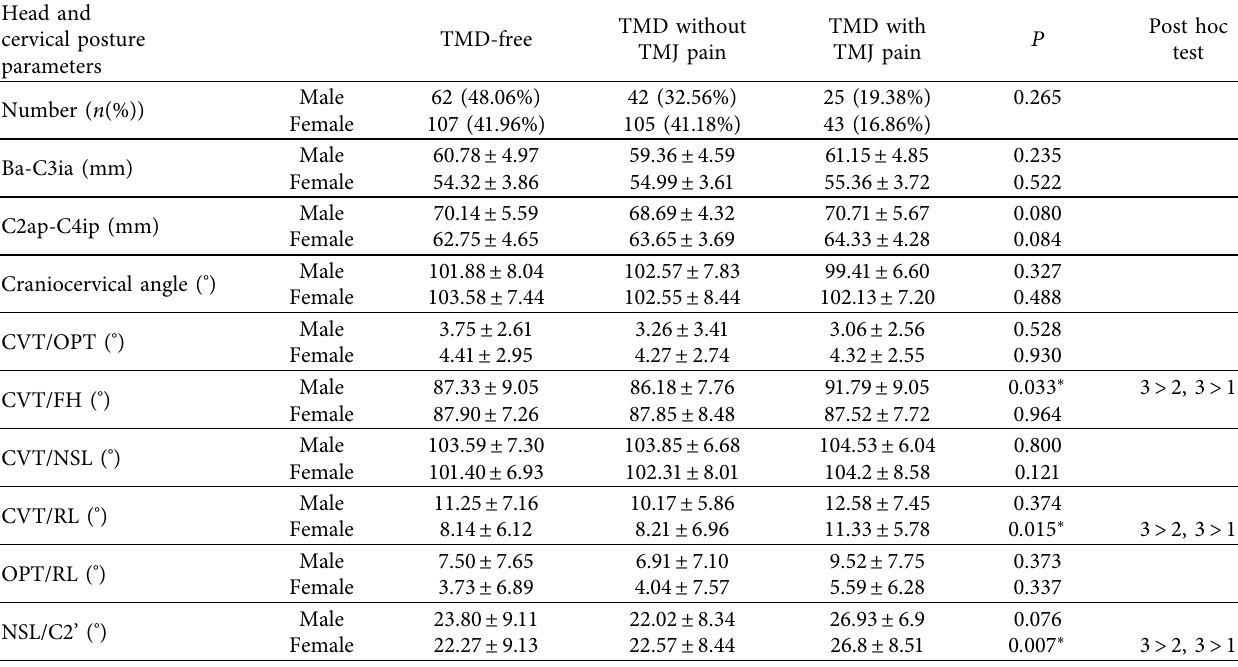
Table 3: Head and cervical posture parameters of TMD-free patients, TMD patients without TMJ pain, and TMD patients with TMJ pain. Head and